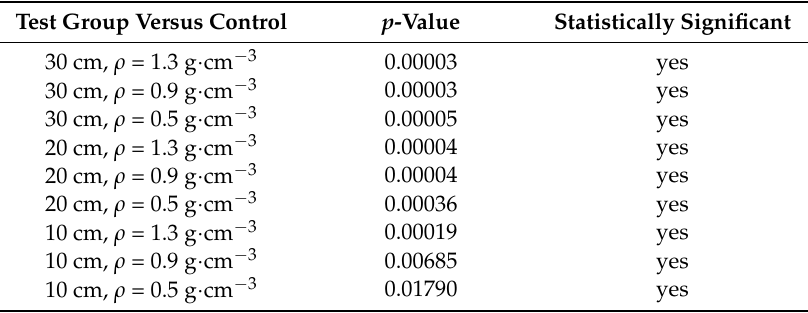
Table 2. Results of the Dunnett ’ s C test (significance level 0.05).